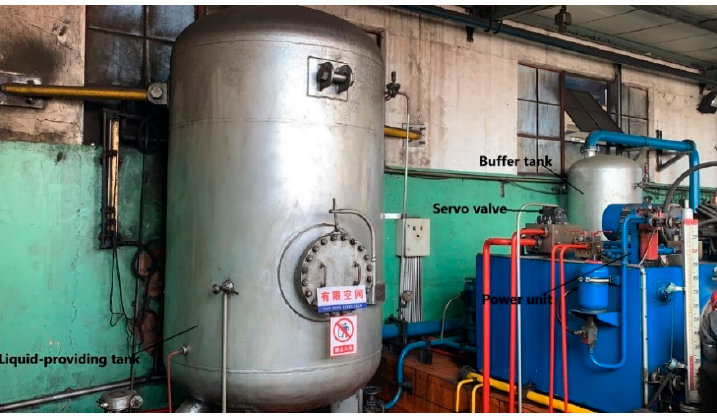
Figure 5. Photograph of the energy-saving bu ff ering system.